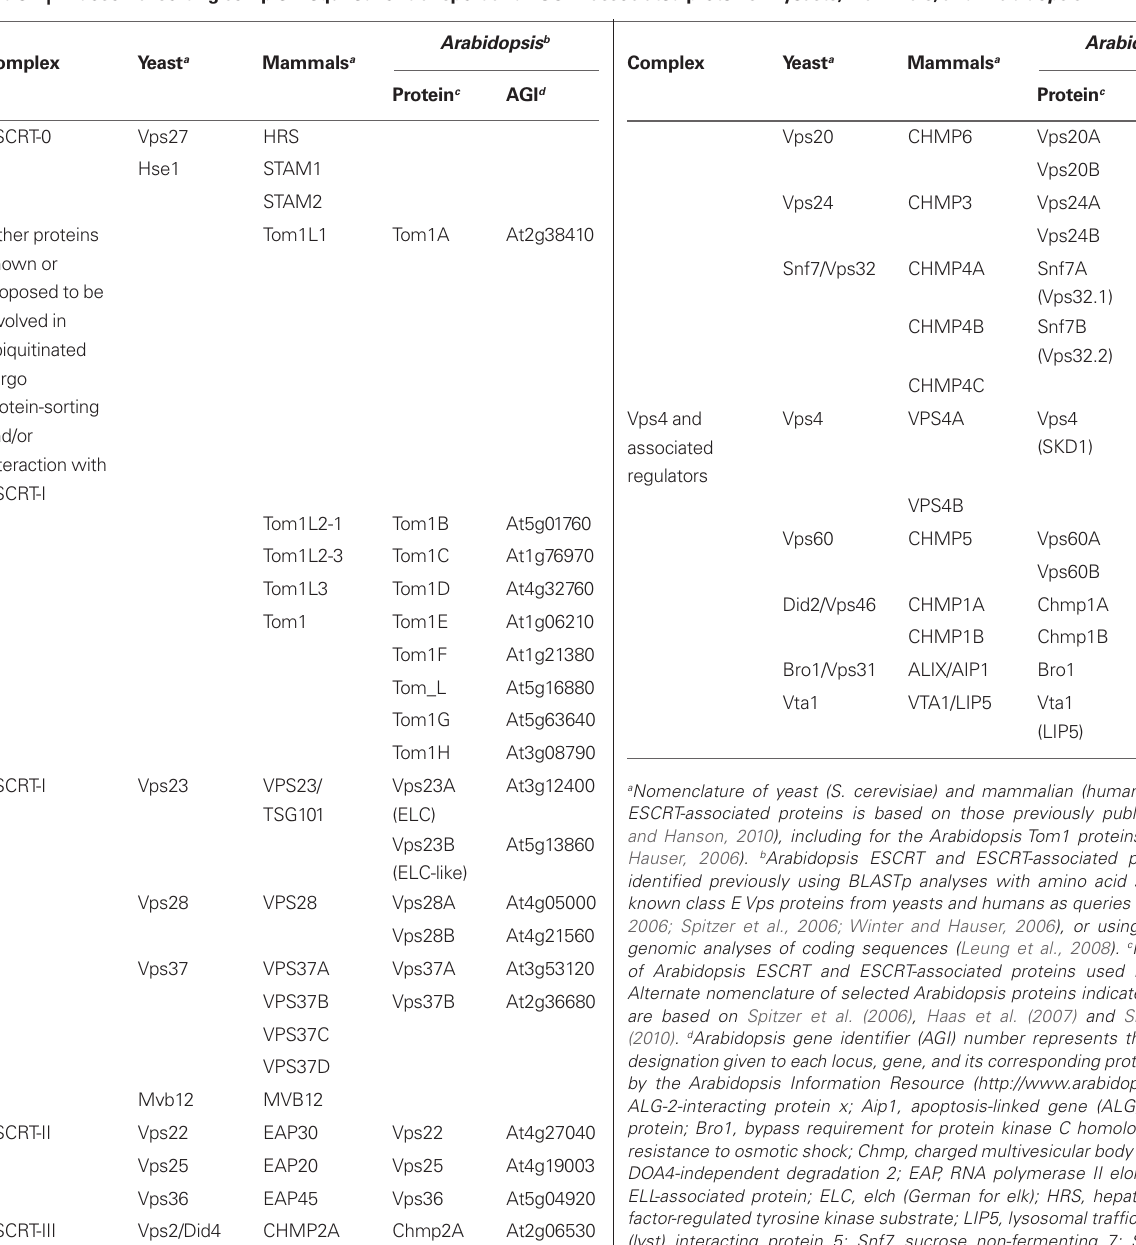
Table 1 | Endosomal sorting complex required for transport and ESCRT-associated proteins in yeasts, mammals, and Arabidopsis